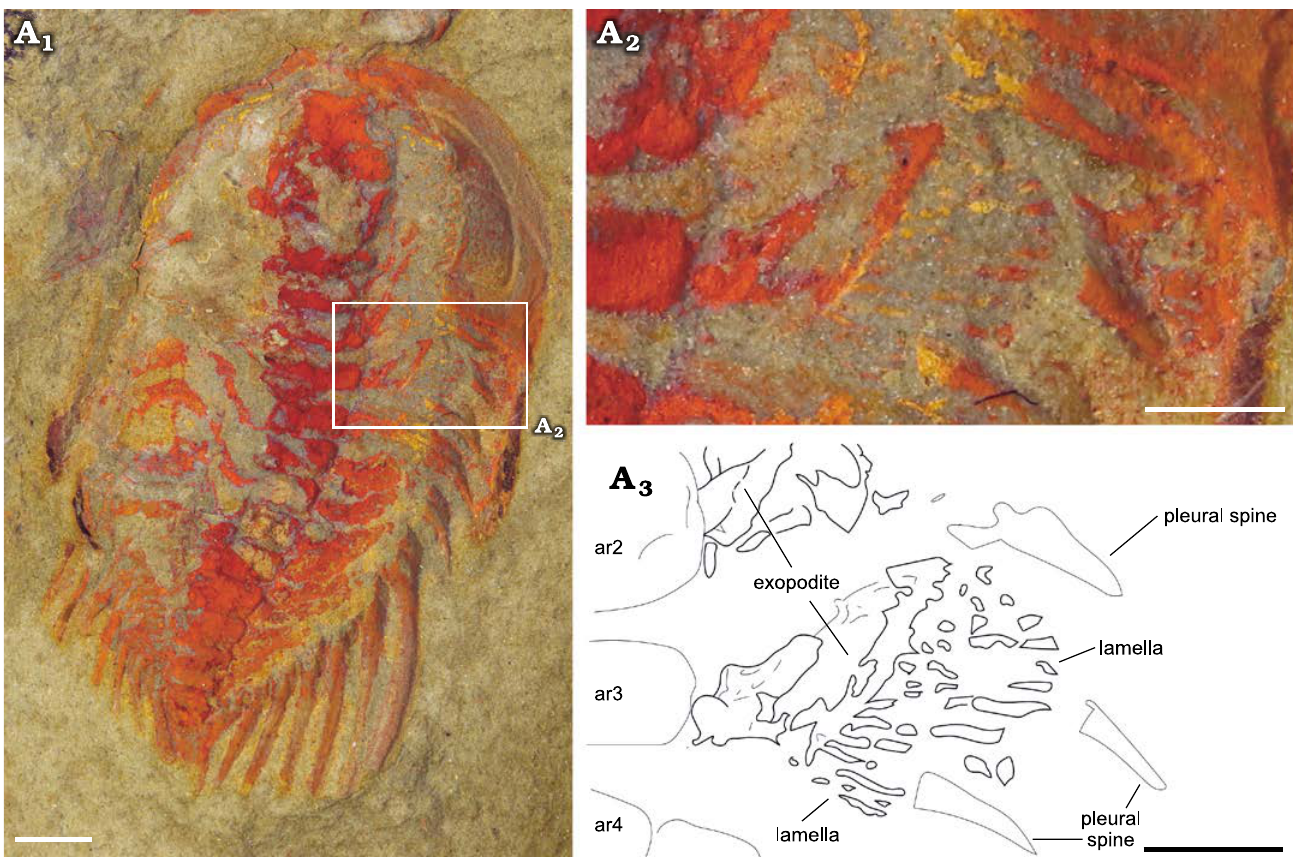
Fig. 6. Cheirurid trilobite Anacheirurus adserai (Vela and Corbacho, 2007) (MGL 102172) from the Fezouata Shale, Araneograptus murrayi Zone, Tremadocian, Lower Ordovician, near Beni Zouli, Zagora Province, Morocco. Photographs under alcohol: general view (A 1 ), close-up of the exopodites (A 2 ) and explanatory drawing (A 3 ). Scale bars 1 mm. Abbreviations: ar, axial